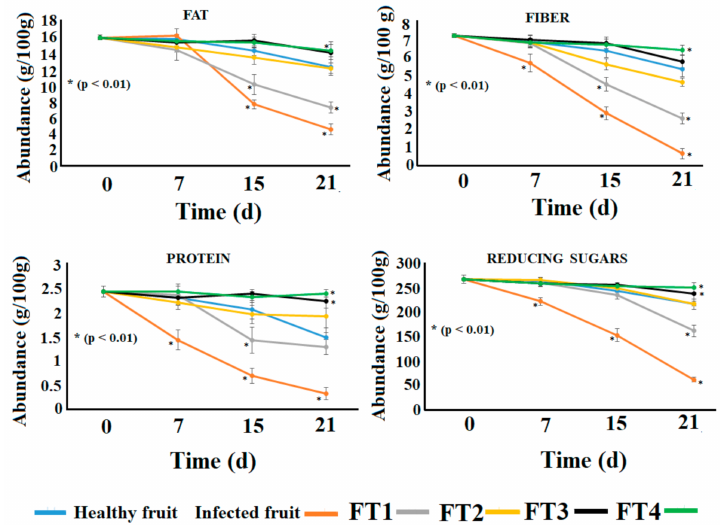
Figure 5. Nutritional parameters of Hass avocadoes treated with the films FT1–FT4 after inoculation with Clonostachys rosea . Points with asterisks indicate means with statistically significant differences by ANOVA-Tukey test in comparison with healthy fruits ( p < 0.01).